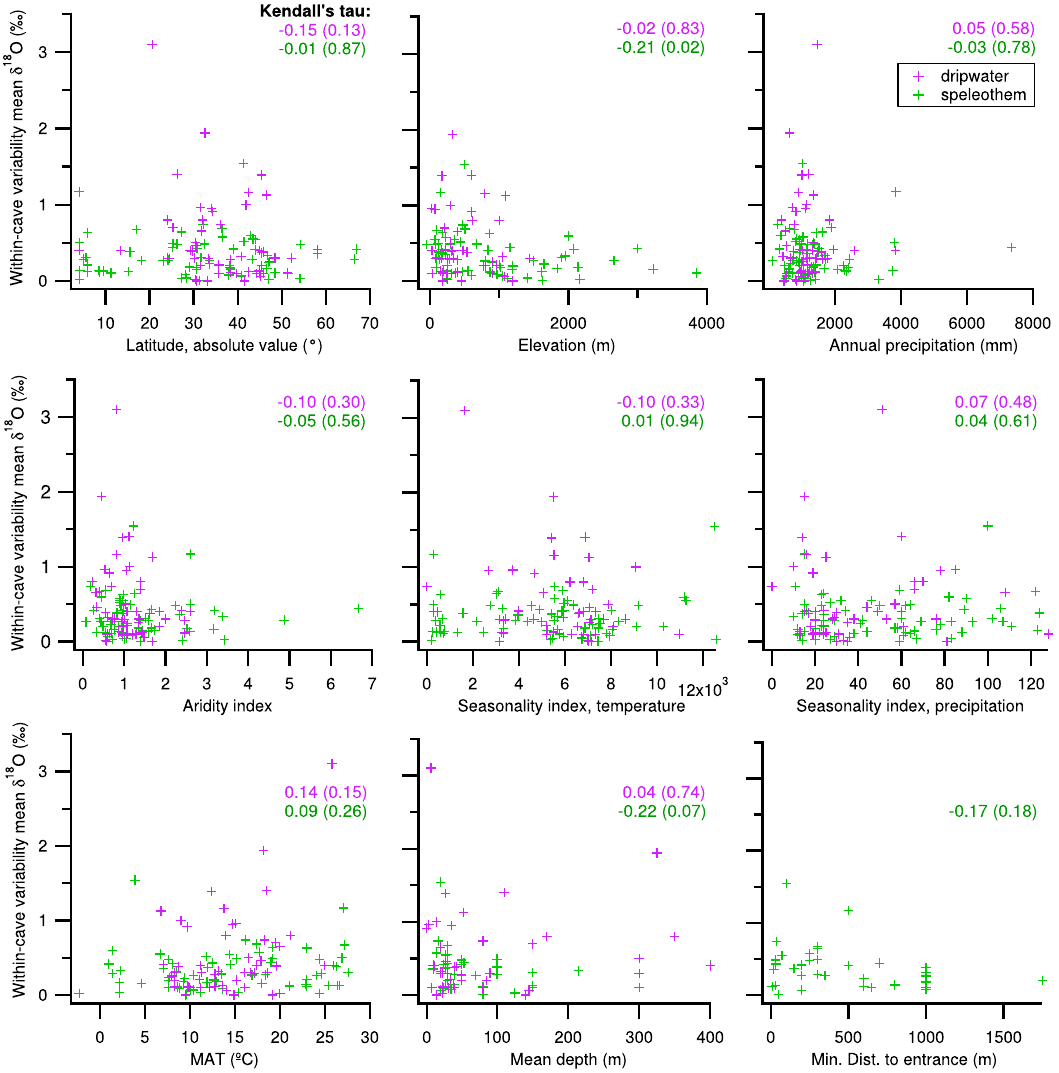
Fig. 3 Cross-plots of within-cave variability in dripwater and speleothem mean δ 18 O values with climate and cave data. Cross-plots show low to no relationships between within-cave differences in dripwater (purple) or speleothem (green) mean δ 18 O values with variables: latitude, elevation, annual precipitation, aridity index, seasonality indices for precipitation and temperature, mean annual temperature, mean depth, and minimum distance from entrance for each cave. The lack of relationship with these variables, demonstrated also by the output from the multiple linear regression models in Supplementary Table 2, supports that karst hydrological heterogeneity is important over all climate types, cave depths and host rock types. Kendall ’ s tau values for each variable ranked against coeval dripwater and speleothem data are also shown, with p -values indicated in brackets. The p -values indicate that none of the relationships in are signi fi cant with the exception of elevation (SISAL; 95%) and mean depth (SISAL; 90%) although the Kendall ’ s tau values are low. Aridity and seasonality indices are